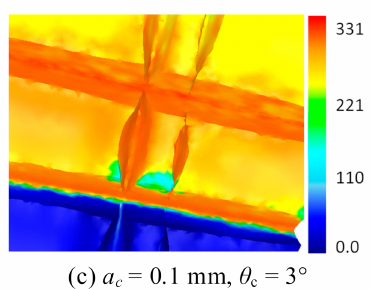
Figure 14. Equivalent stress distribution under di ff erent feeding angles. ( a ) θ c = 1 ◦ ; ( b ) θ c = 2 ◦ ; ( c ) θ c = 3 ◦ .